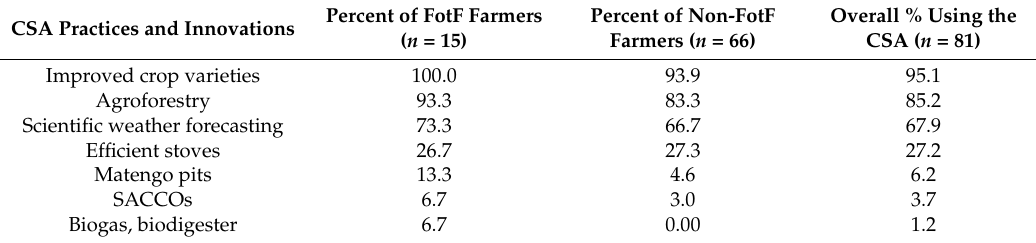
Table 3. Uptake of CSA practices and innovations farmers were exposed to during the learning